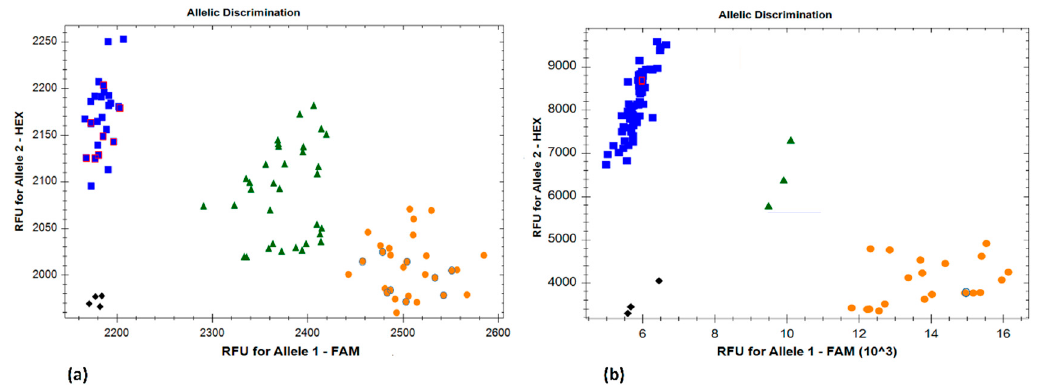
Figure 2. Kompetitive allele-specific polymorphism (KASP) marker SNP113325 identifying the resistant and susceptible parents and selected progenies of ( a ) an Ae. tauschii (TA2450 / TA2433) F 2 population; ( b ) a hexaploid wheat (KS93U50 / Morocco) F 5 RIL population. Blue: susceptible homozygotes; green: heterozygotes; orange: resistant homozygotes; black: non-template controls. The parental resistant (orange with a blue border) and susceptible (blue with a red border) lines have been highlighted in the respective figures.